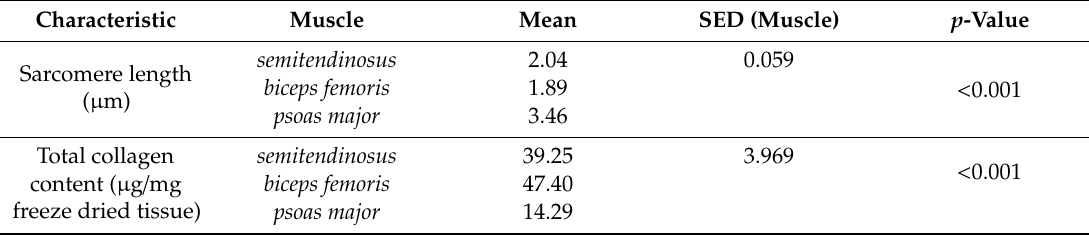
Table 2. Predicted means for sarcomere length ( µ m) and total collagen content ( µ g / mg freeze dried tissue) of bovine semitendinosus , biceps femoris and psoas major